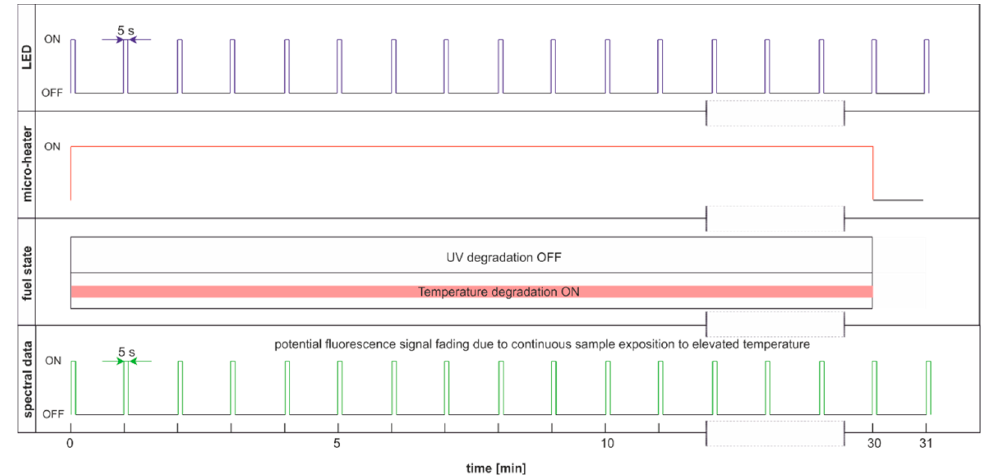
Figure 16. Degradation and examination cycle of fuel with UV use named DCE:UVoffTon.